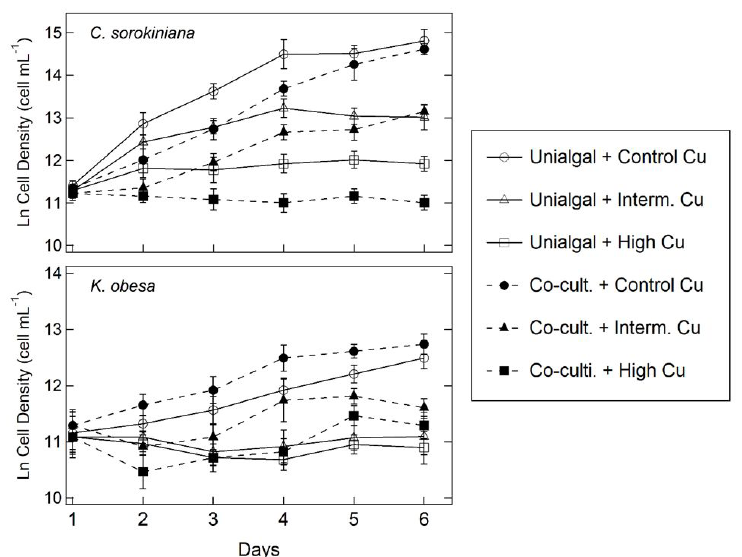
Figure 1. Population density (Ln cell mL -1 ) of Chlorella sorokiniana (up) and Kirchneriella obesa (down) in unialgal conditions (continuous line, unfilled symbols) and co-cultivation (dashed line, filled symbols) as a function of experimental period in days with mean ± standard deviation. Copper concentration symbols: circle (control,